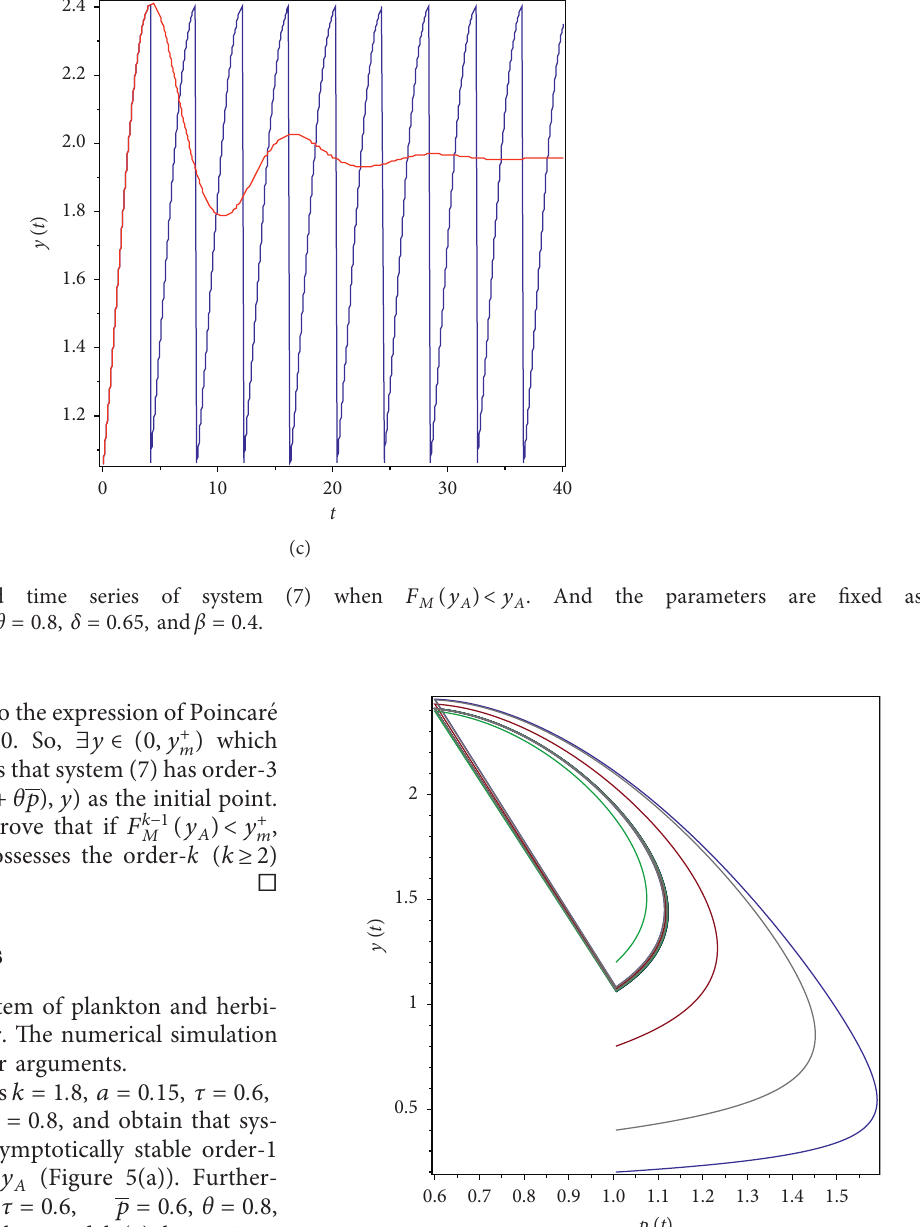
Figure 7: Periodic solution of system (7) at different initial points. And the parameters are fixed as k � 1 . 8 , a � 0 . 15 , τ